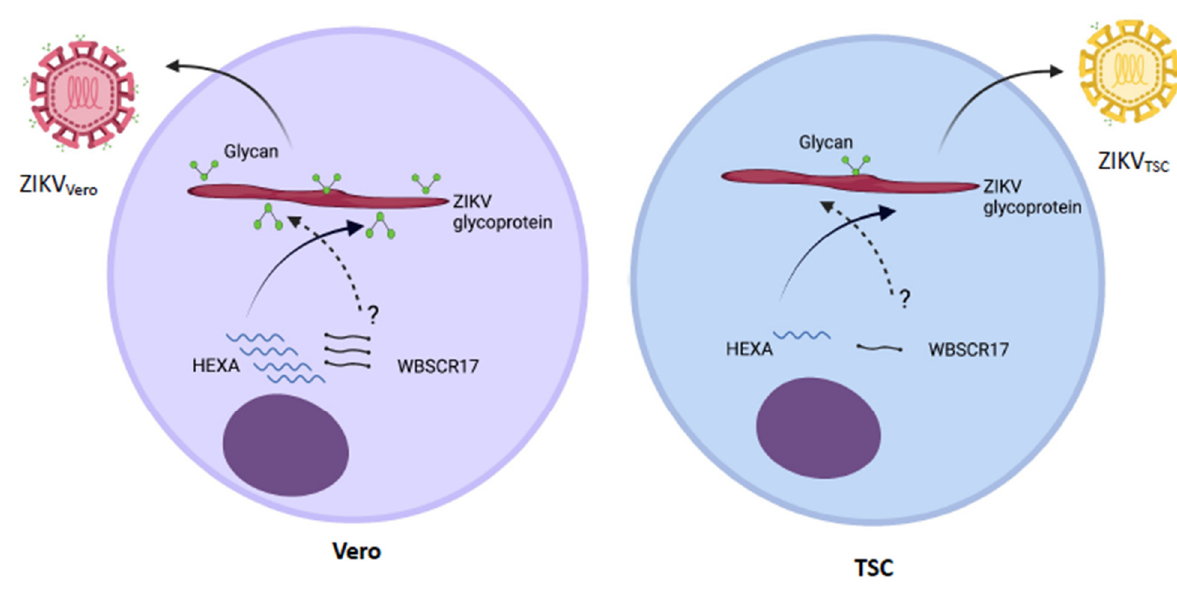
Figure 7. Schematic illustration of the mechanism of HEXA-mediated glycosylation of ZIKV proteins. Vero cells produce HEXA and possibly WBSCR17 during ZIKV replication, which facilitate the glycosylation of ZIKV E and other glycoproteins. In contrast, TSCs and DTSCs have a reduced level of HEXA during ZIKV replication, resulting in less glycosylation of ZIKV E proteins, which attenuates ZIKV binding to GAG receptors. Created with Biorender.com.